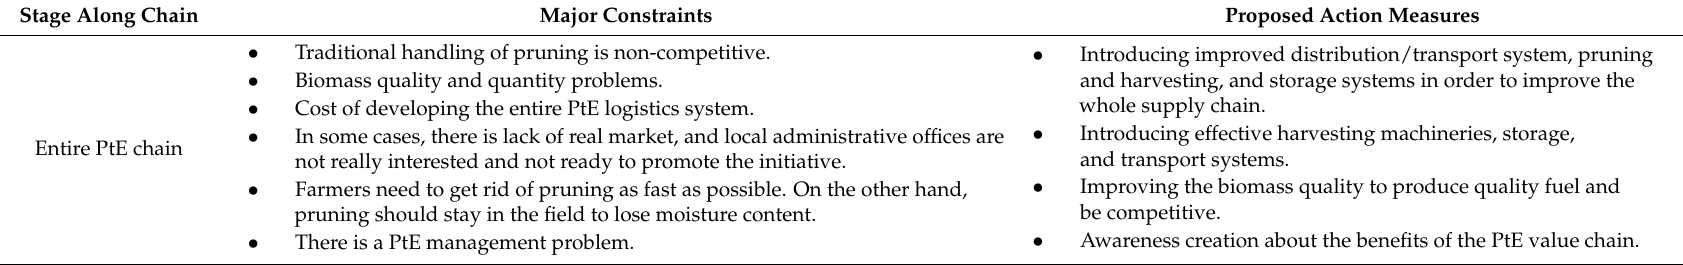
Table 7. Major constraints and proposed action